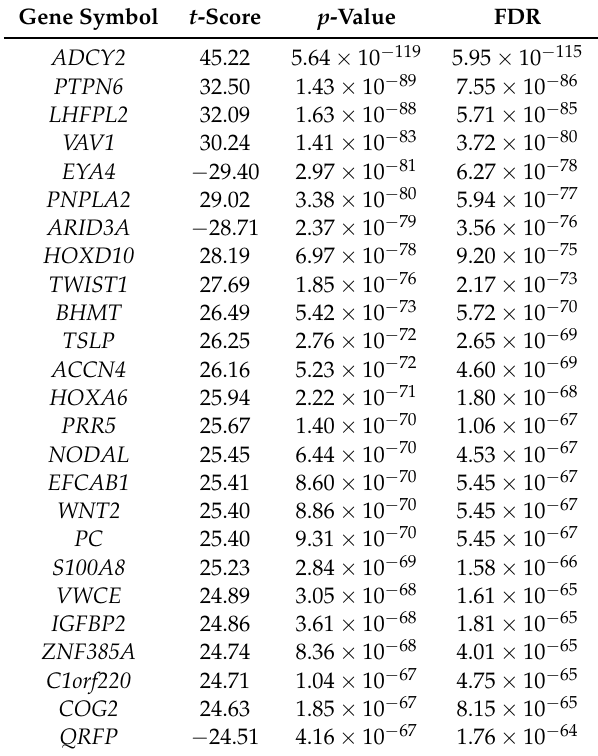
Table 1. List of differentially expressed genes (false discovery rate (FDR)